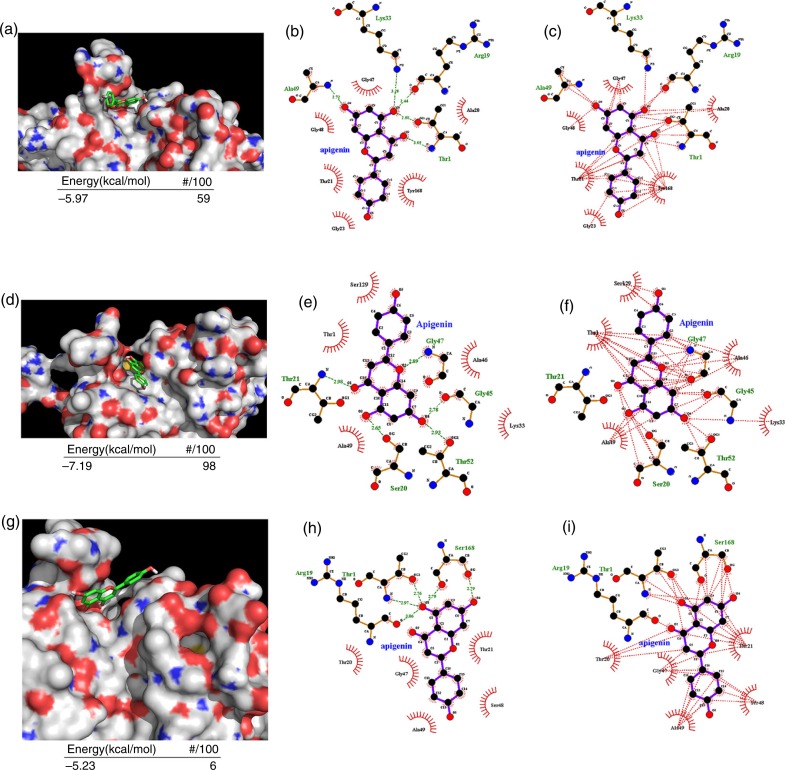
Molecular docking of apigenin on the proteasome subunits. (a–c) Apigenin was docked to β5 subunit of the proteasome. The energy of the inhibitory pose and the number of runs (out of 100) that adopted the inhibitory pose was shown below (a). The threonine catalytic residue and all amino acids in the S1 pocket of β5 subunit involved in the formation of H-bonds (b) and hydrophobic interactions (c) with apigenin are highlighted. (d–f) Apigenin was docked to β2 subunit of the proteasome. The energy of the inhibitory pose and the number of runs (out of 100) that adopted the inhibitory pose was shown below (d). The threonine catalytic residue and all amino acids in the S1 pocket of β2 subunit involved in the formation of H-bonds (e) and hydrophobic interactions (f) with apigenin are highlighted. (g–i) Apigenin was docked to β1 subunit of the proteasome. The energy of the inhibitory pose and the number of runs (out of 100) that adopted the inhibitory pose was shown below (g). The threonine catalytic residue and all amino acids in the S1 pocket of β1 subunit involved in the formation of H-bonds (h) and hydrophobic interactions (i) with apigenin are highlighted.